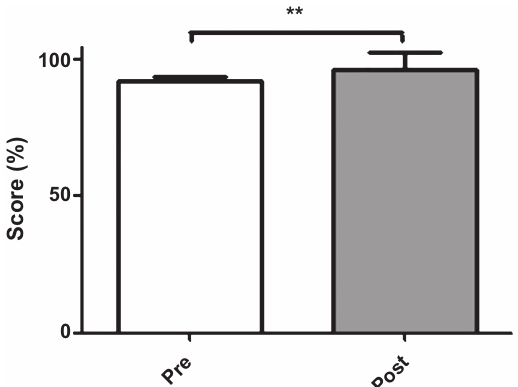
Table 2. Percentage of the